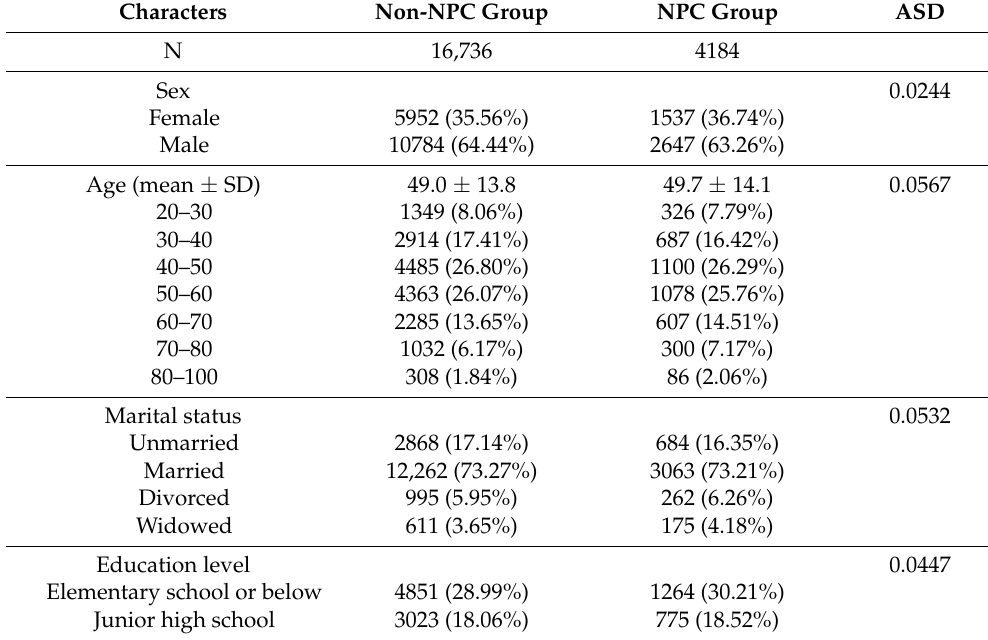
Table 1. Characteristics of nasal pharyngeal carcinoma patients and control group after propensity- score